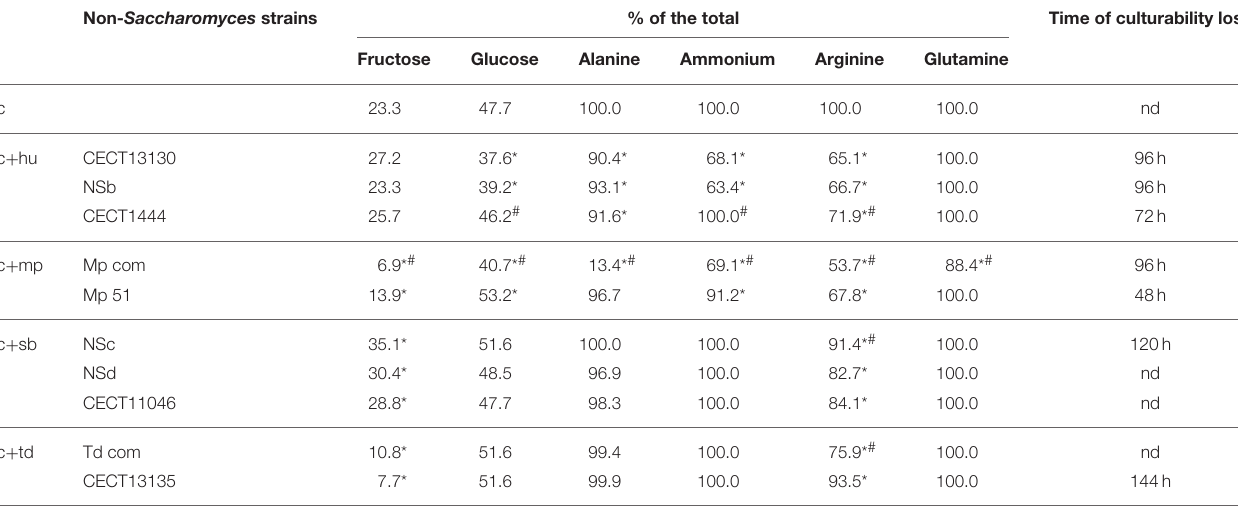
TABLE 2 | Consumption ratio of glucose, alanine, ammonium, arginine, and glutamine at 24h of fermentation. Non- Saccharomyces strains % of the total Time of culturability loss Fructose Glucose Alanine Ammonium Arginine Glutamine